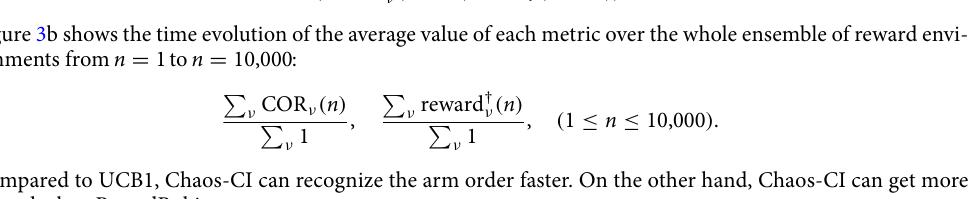
10,000 under one reward environment ν : = n 10,000 ≤ ≤